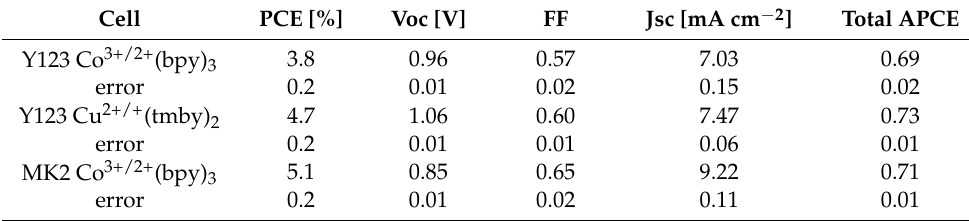
Table 1. Photovoltaic parameters of the studied solar cells (before irradiation) 1